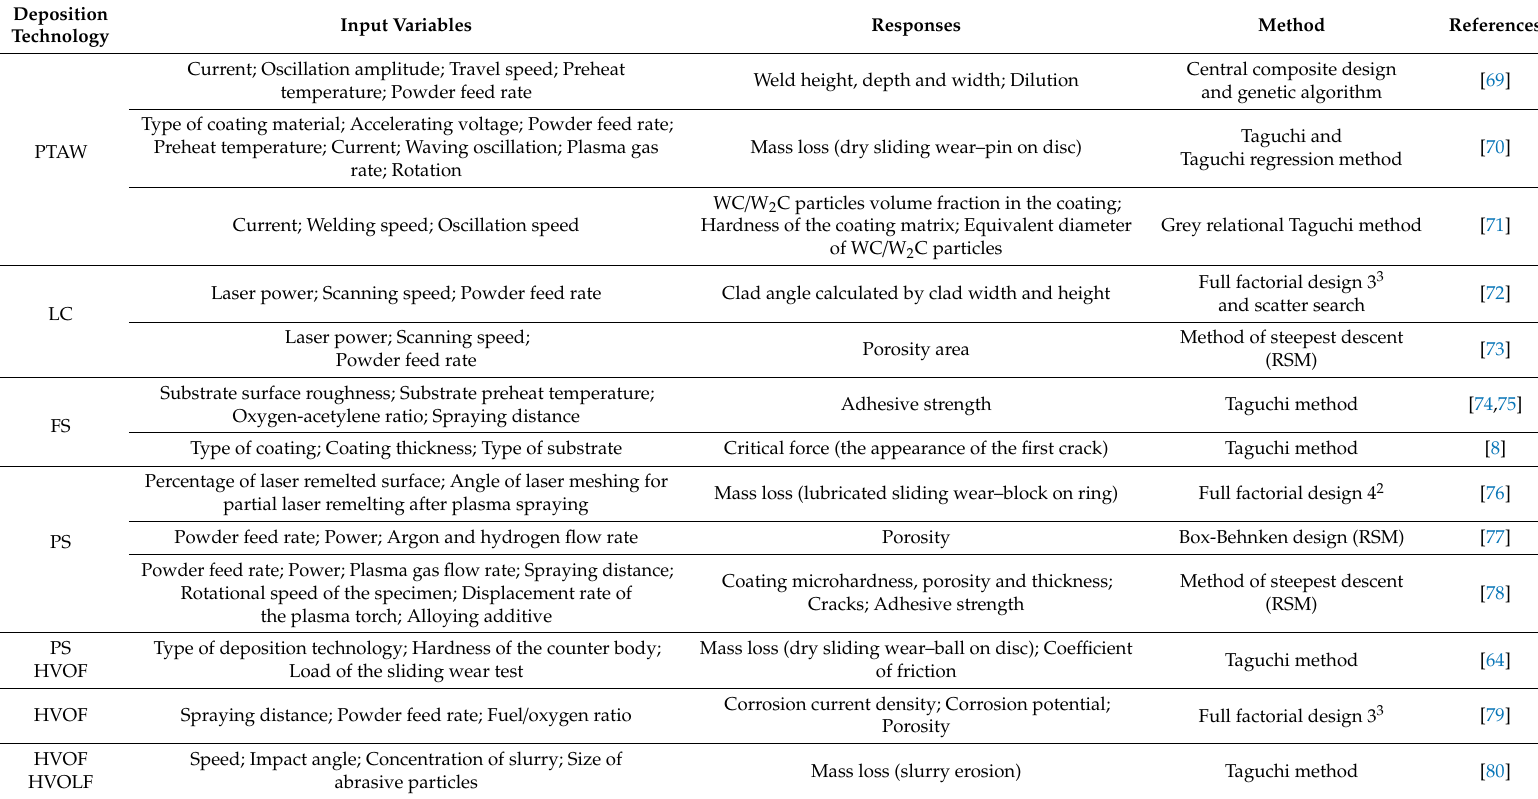
Table 3. Summary of investigations for the optimization